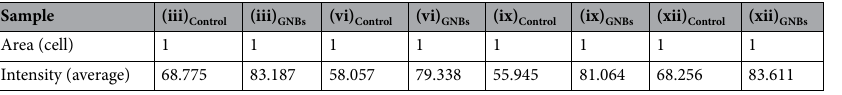
Table 7. Fluorescence intensity values of control cells and experimental cells (incubate with GNBs with an aspect ratio of 2.92) in Fig. 6b.